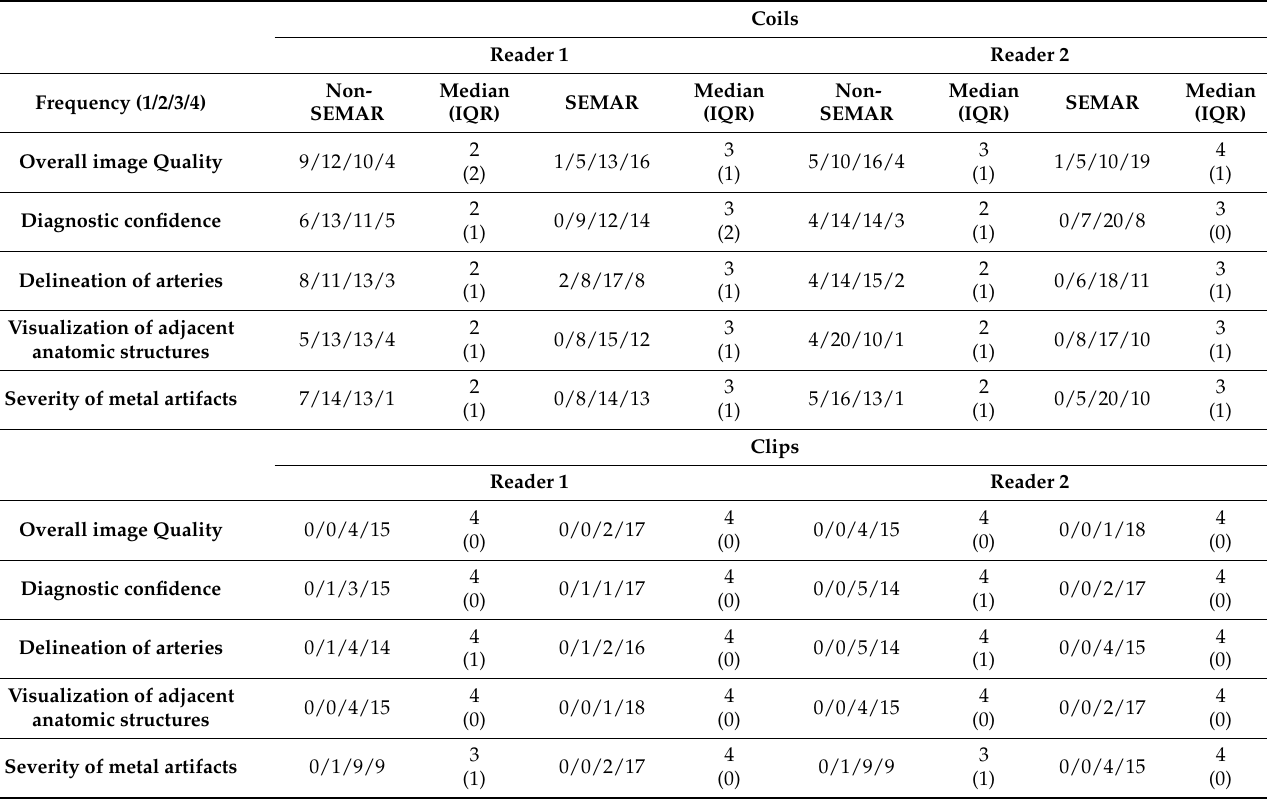
Table 3. Results of the qualitative image evaluation. Data shows frequency of the Likert scale scores in each category of the qualitative image evaluation and the calculated median and interquartile